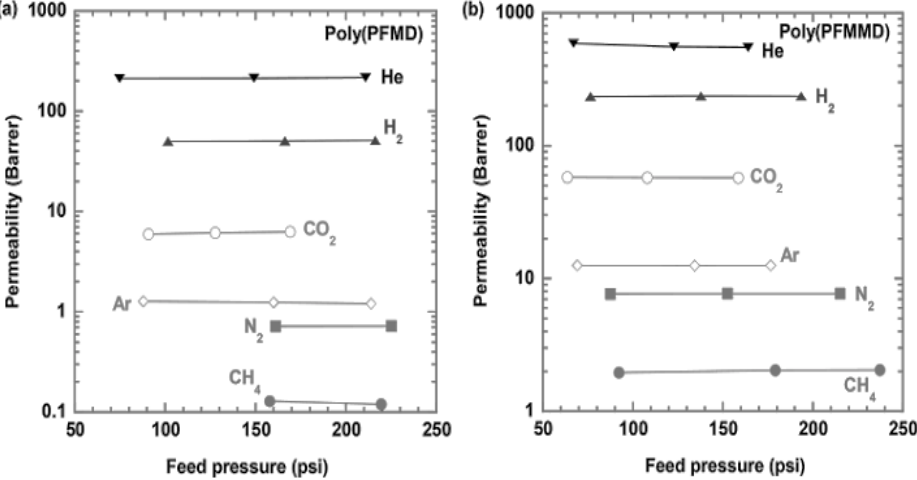
Figure 8. Effect of feed pressure on the pure-gas permeability of the freestanding films at 35 °C for ( a ) Poly(PFMD) and ( b ) Poly(PFMMD).